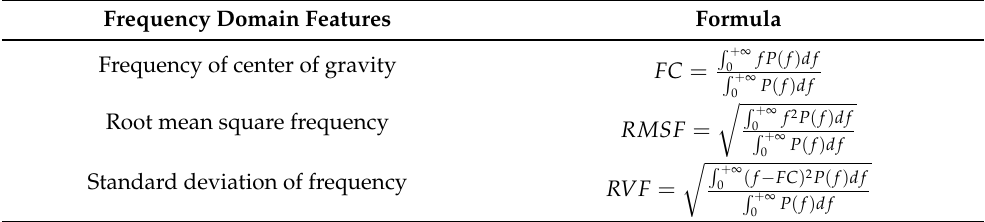
Table 5. Frequency domain